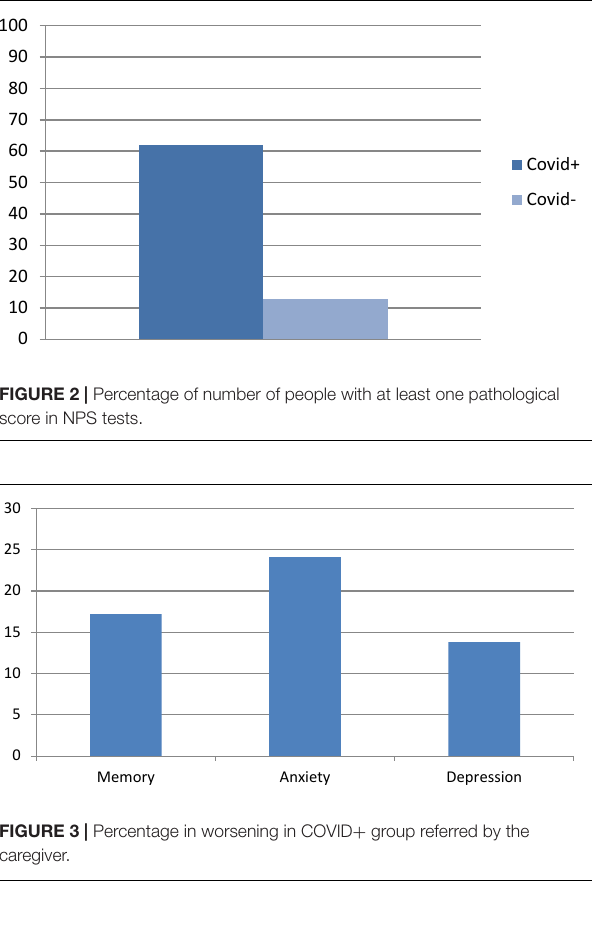
one’s compared to their status before infection (see Figure 3 for